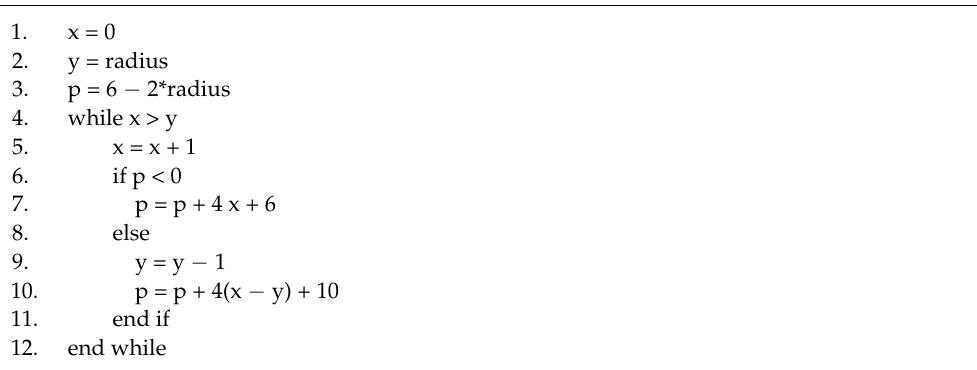
Algorithm 1: Bresenham Circle Point Generation.